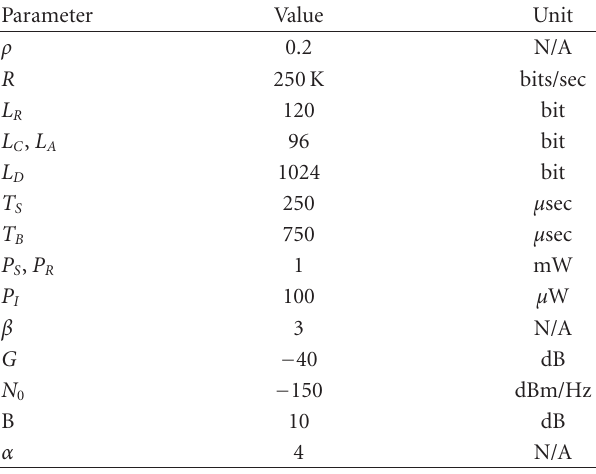
Table 2: Parameters in the